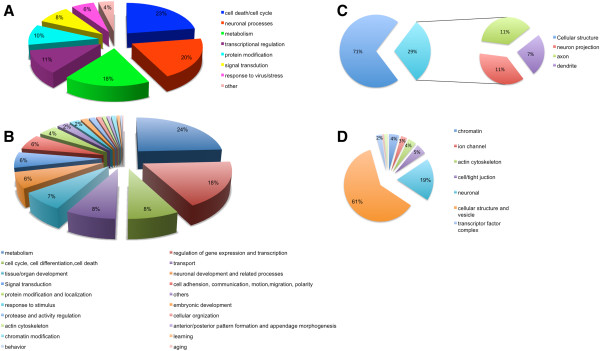
Representation of gene ontology cellular components and biological processes of mRNA and miRNA profiles. A pie chart representation of biological processes and cellular components, where each part represents -log2 of the P-value of biological process and cellular component from the set of significant biological processes and cellular components. The total of -log2 of the P-value is 1. The P-values were retrieved from gene ontology analysis in DAVID. A. Biological processes of mRNA profiles. B. Biological processes of miRNA profiles. C. Cellular components of mRNA profiles. D. Cellular components of miRNA profiles.